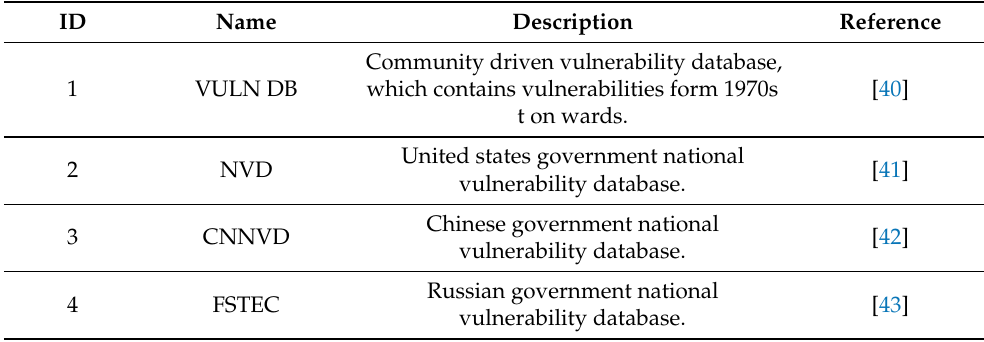
Table 6. Tools used for OSINT on vulnerability